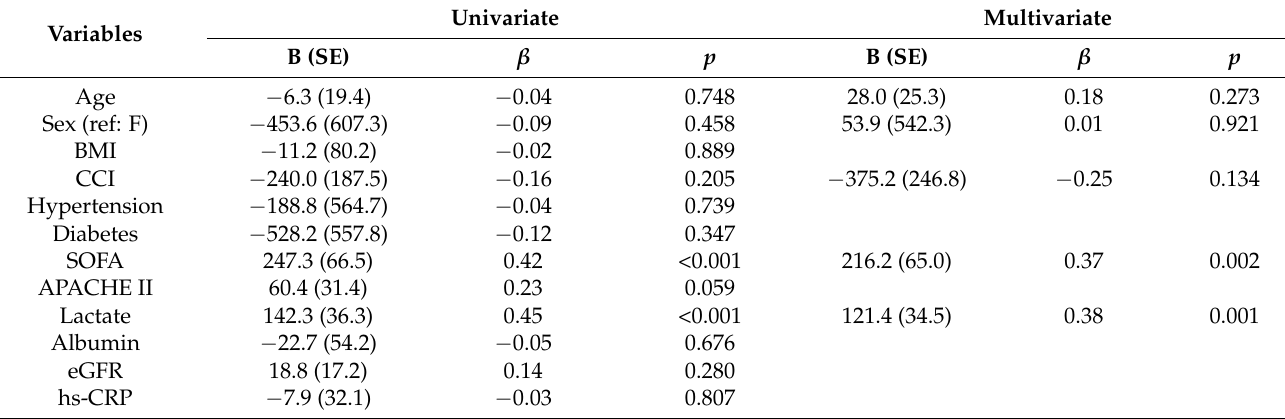
Table 4. Associated factors for GDF-15 in linear regression